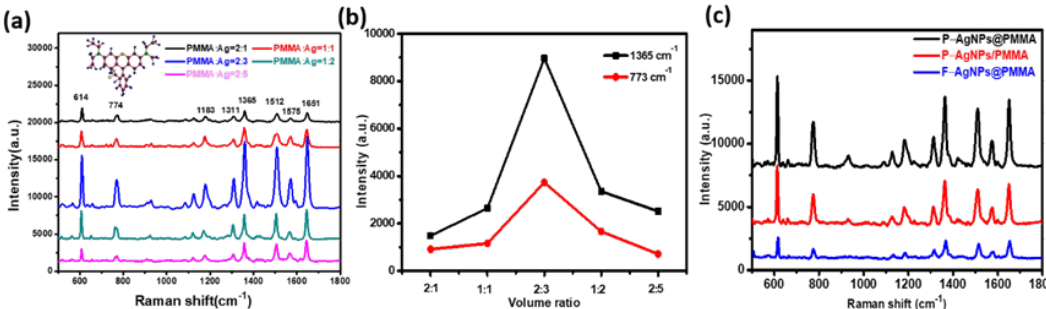
Figure 3. ( a ) The surface-enhanced Raman scattering (SERS) spectra obtained from the P–AgNPs@PMMA substrate with di ff erent PMMA / Ag volume ratio; here, the concentration of rhodamine 6G (R6G) is 10 − 7 M. Insert: the structural formula of R6G molecule; ( b ) change in Raman intensity of R6G at 774 and 1365 cm − 1 as a function of volume ratio; ( c ) SERS spectra of 10 − 7 M R6G absorbed on